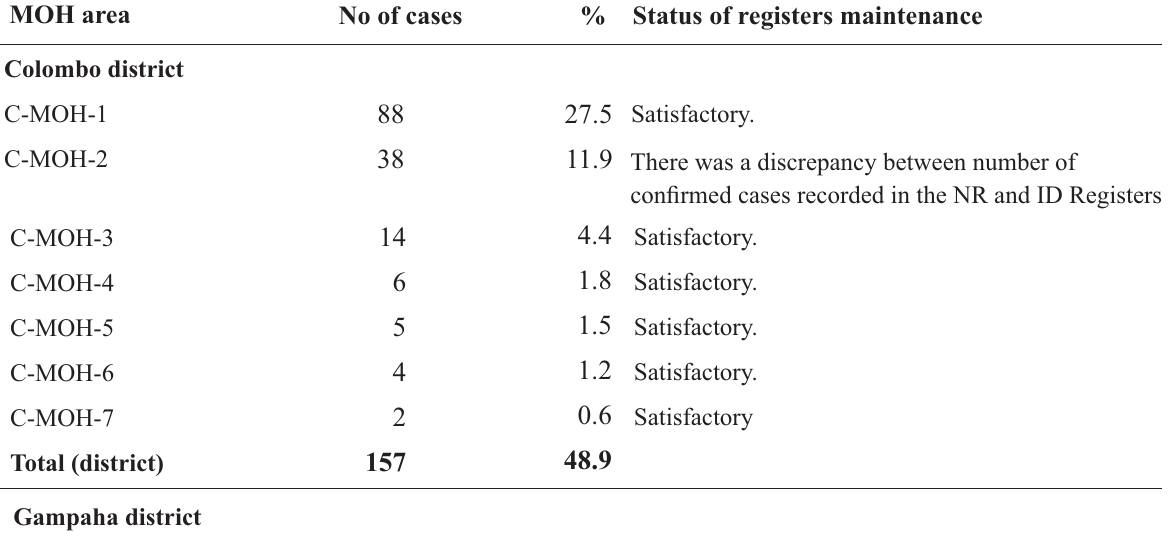
Table 6: Distribution of status of Register maintenance by selected MOH areas in the Western